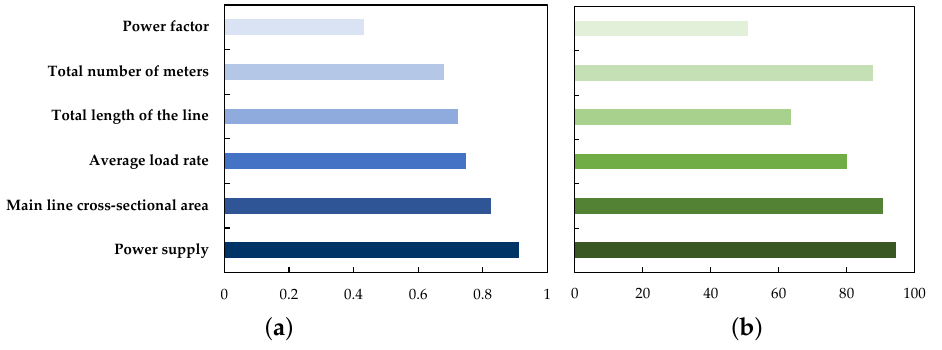
Figure 4. Contribution of each feature. ( a ) Spearman’s rank correlation coefficient, and ( b ) GBDT relative